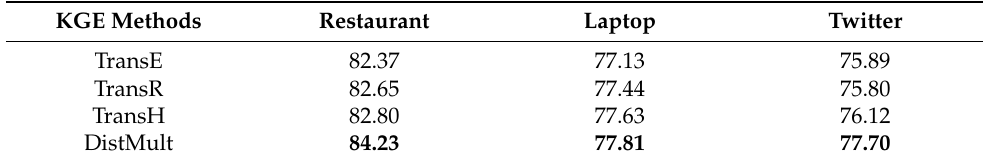
Table 4. ALSC results of different KGE